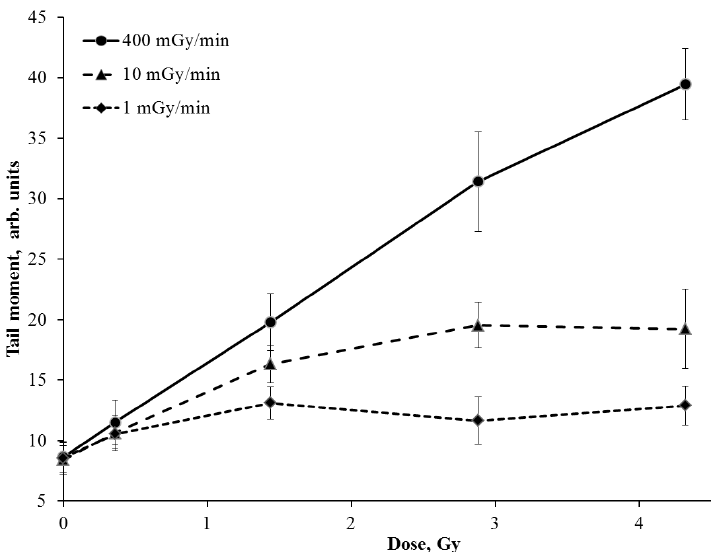
Figure 2. Changes in the DNA fragmentation level in Chinese hamster V79 cells exposed to γ-rays at high (400 mGy/min), medium (10 mGy/min) and low (1 mGy/min) dose